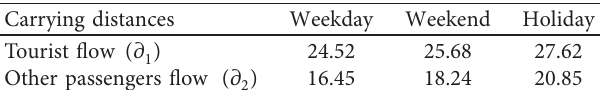
Table 7: Average carrying distances of taxis with different pas- senger flows on different days (km).